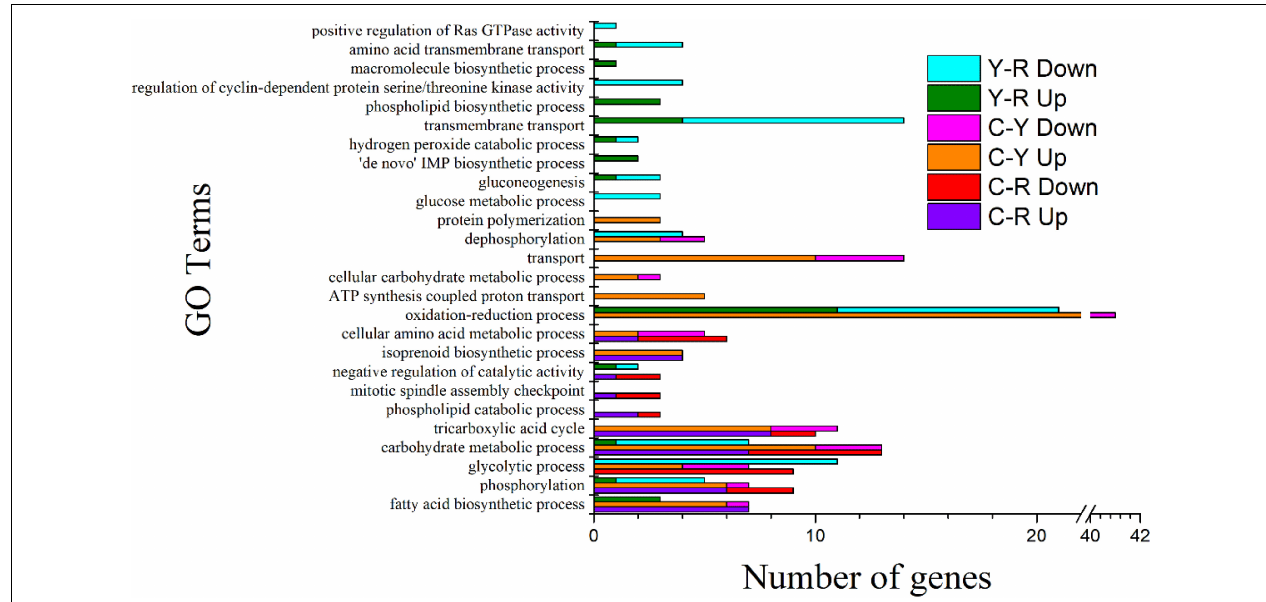
FIGURE 4 | GO Terms of biological process identified in S. cerevisiae transcripts in response to different conditions. C-R, comparison of transcripts from the yeast cultured under between calcium acetate medium and control; C-Y, comparison of transcripts from the yeast cultured under between calcium lactate medium and control Y-R, comparison of transcripts from the yeast cultured under between calcium acetate medium and calcium lactate medium; Up, up-regulated genes; Down, down-regulated genes.